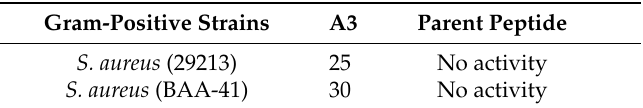
Table 6. MBEC values of A3 and AamAP1 against biofilm-forming bacterial strain of S. aureus. MBEC values are displayed in ( µ M) concentration. Results represent triplicates.